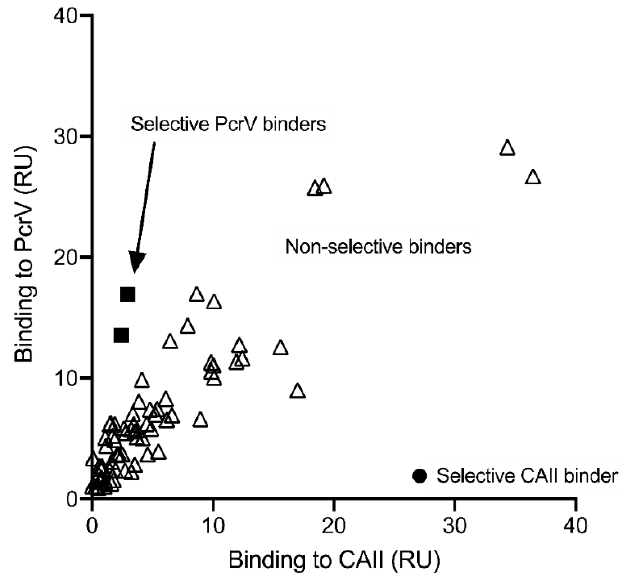
Figure 2. The x -axis shows the binding levels to the immobilized deactivated control protein arbonic anhydrase isoenzyme II from bovine erythrocytes (CAII), and the y -axis shows the binding levels (the average of two channels) to the immobilized PcrV protein for compounds from one exemplified screening plate. The binding levels (in resonance units (RU)) were blank subtracted, molecular weight adjusted, and multiplied by 100. The values on the y -axis show an average value of the binding levels to PcrV proteins immobilized in two channels while the binding level on the x -axis is from CAII immobilized in one channel. Two compounds that bind to PcrV with a higher selectivity than to CAII are shown as filled squares (“selective PcrV binders”, one is H1 (Table 1)). One selective binder to CAII are marked with a filled circle (“selective CAII binder”). The remaining compounds are shown as triangles.